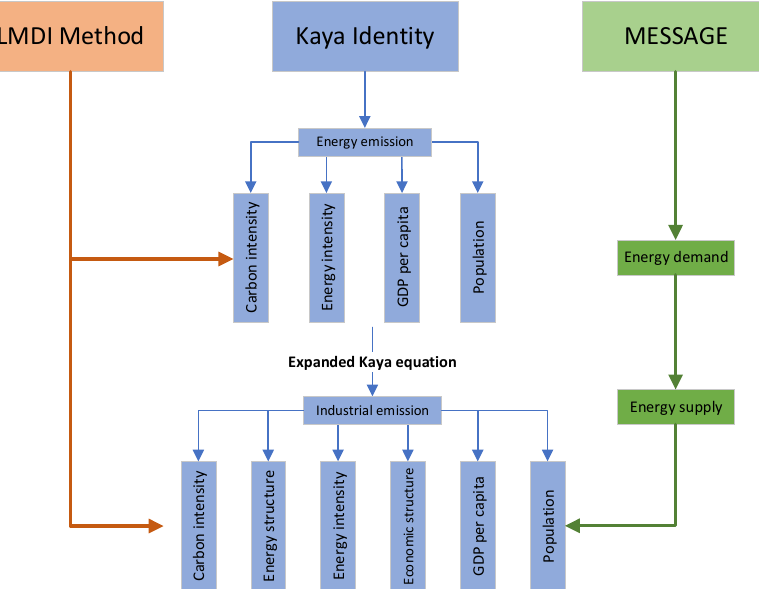
Figure 2. The framework of present and projection analysis on industrial emission reduction based on MESSAGE optimization and expanded Kaya equation with LMDI decomposition.